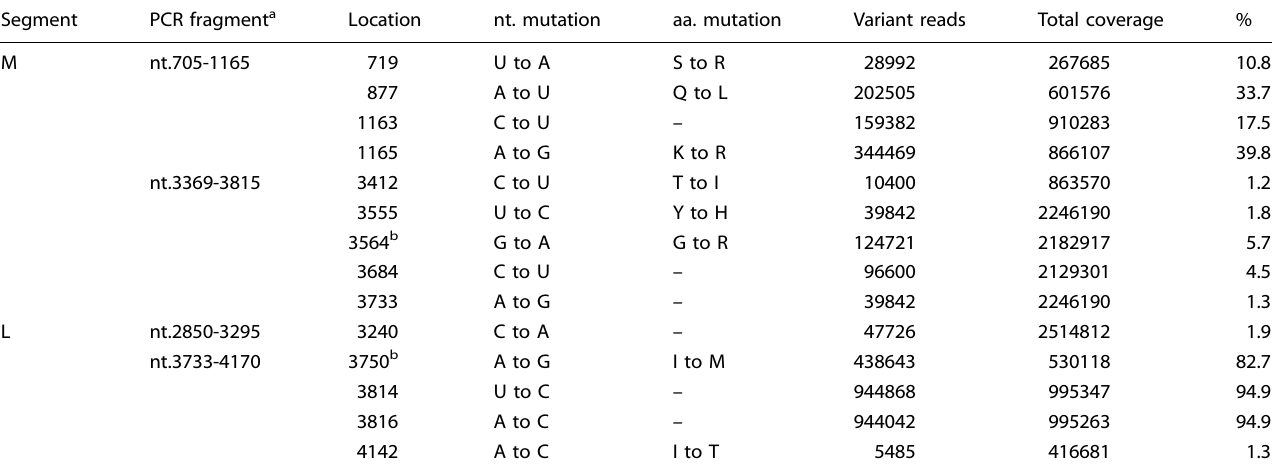
Table 1. Illumina MiSeq amplicon sequencing for rMP12- Δ NSs16/198 (Vero cells, Exp-1, p25)